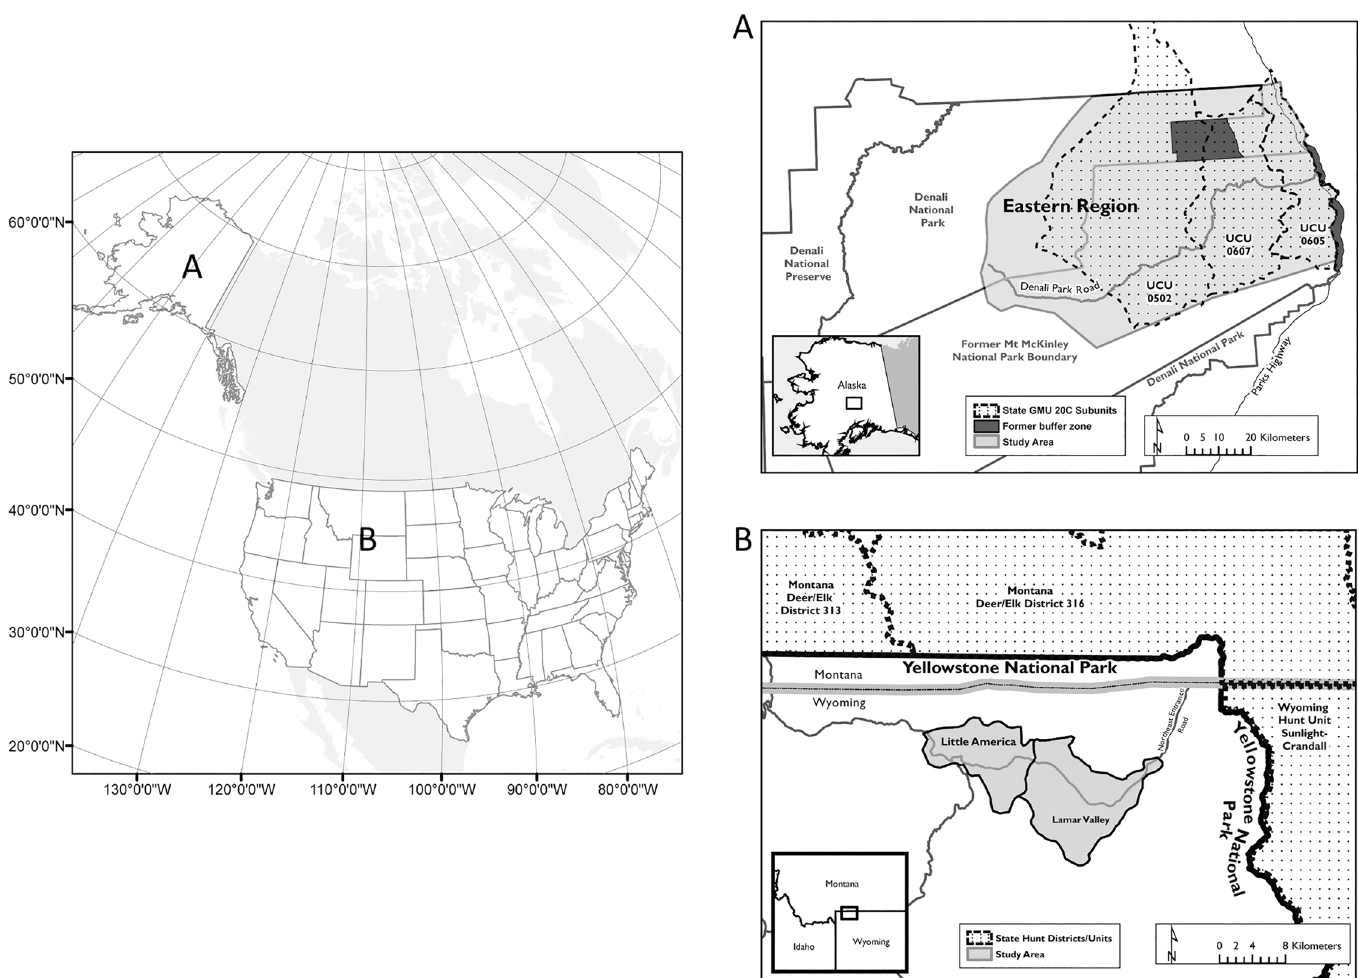
Fig 1. Map of study areas for monitoring wolf sightings in the United States : A) Denali National Park and Preserve study area with Uniform Coding Units (UCUs) within Game Management Unit 20C and former buffer zone where wolf hunting and trapping was prohibited from 2000 to 2010 shown and, B) Yellowstone National Park study area within the Northern Range with adjacent state hunt districts/units